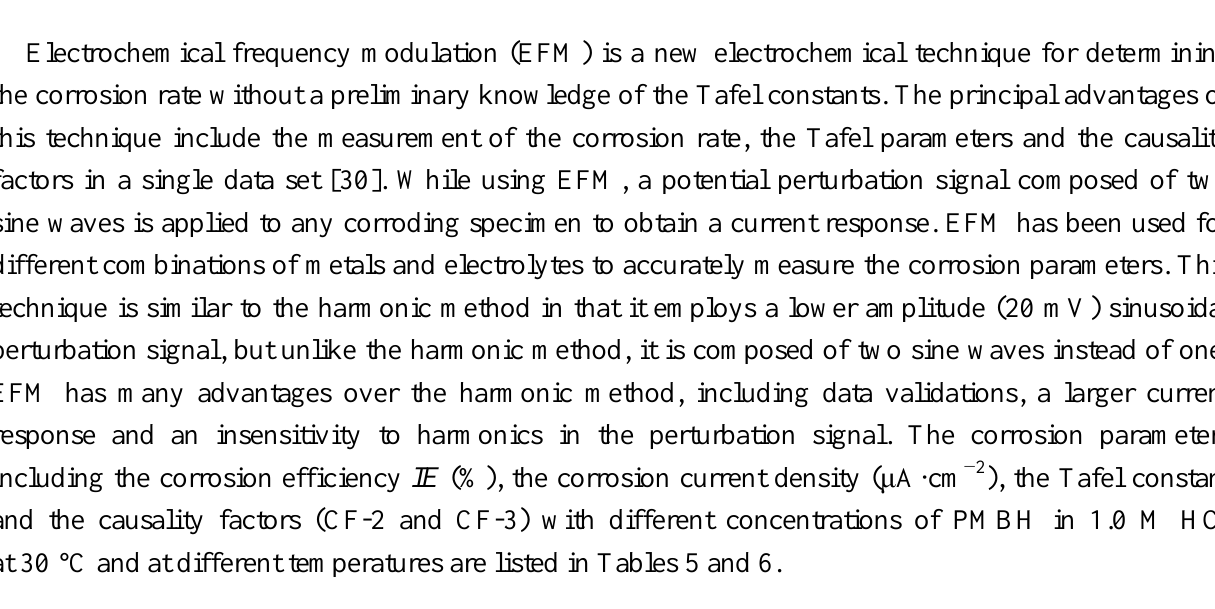
Table 5. The electrochemical frequency modulation (EFM) parameters for mild steel in 1.0 M HCl with various concentrations of the PMBH at 30 °C.